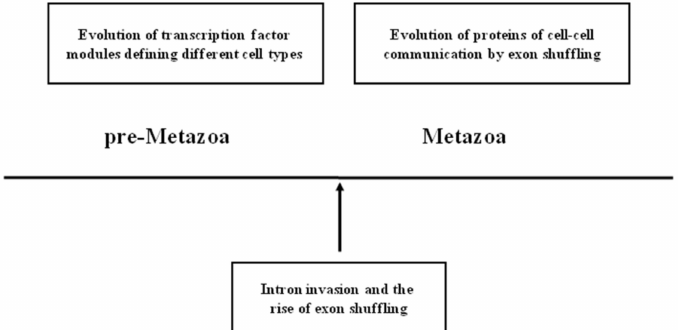
Figure 1. Schematic representation of the relative timing of the key events leading to the emergence of metazoan-type multicellularity. The figure emphasizes that the evolution of transcription factor modules defining different cell types of unicellular and colonial pre-Metazoa preceded the intron invasion that led to the rise of exon shuffling and the creation of cell–cell communication proteins that are essential for complex multicellularity of